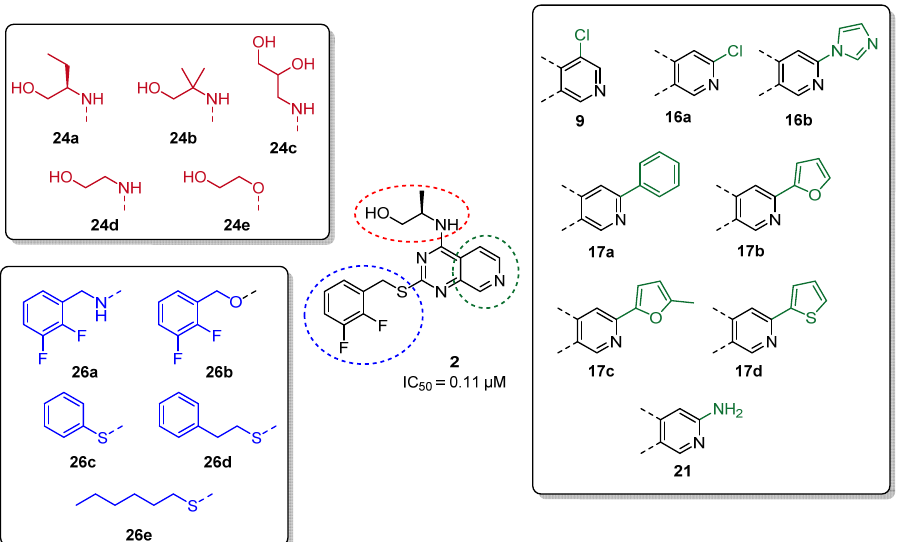
Figure 3. Summary of the SAR study. The compounds shown in red ( 24a – e ) represent the 4-position variations, shown in blue ( 26a – e ) the 2-positions variations, and those shown in in green ( 9 , 16a , 16b , 17a , 17b , 17c and 21 ) the 5- and 6-positions variations.